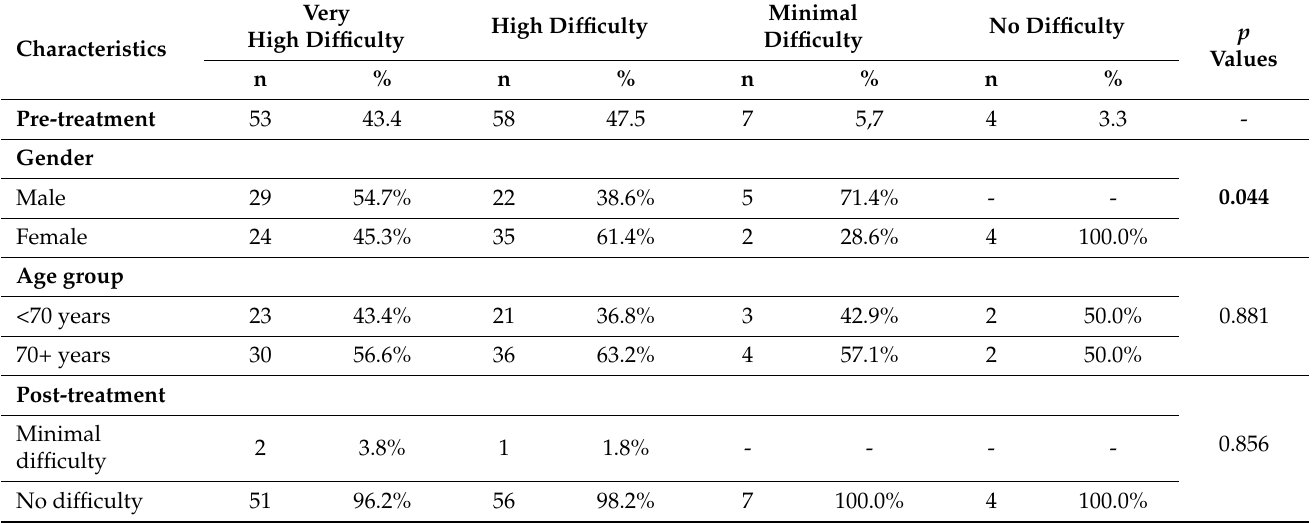
Table 8. The percentage distribution of patients with difficulties in seeing during hobbies according to pre- and post-treatment study group